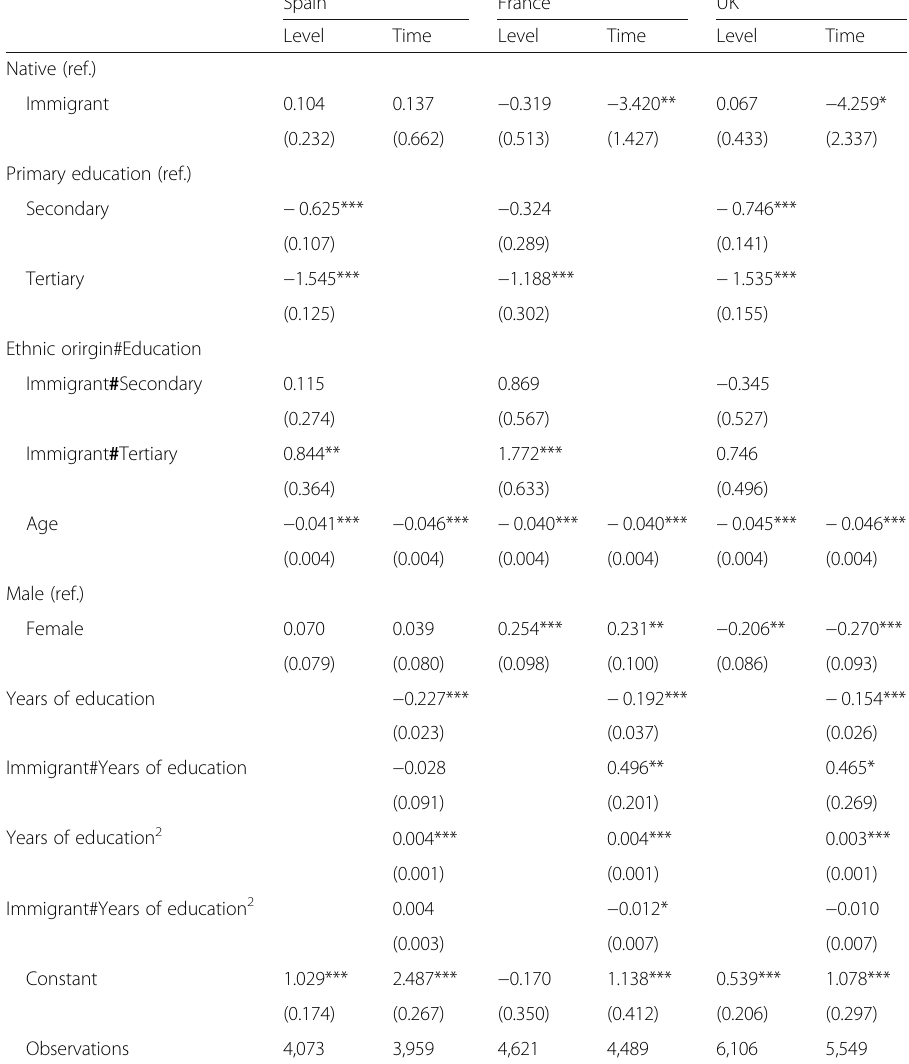
Table 3 Logistic regression on the probability of being unemployed vs. employed (ref.). Gross models (0) controlling separately for educational level and time of education Spain France UK Level Time Level Time Level Time Native (ref.)